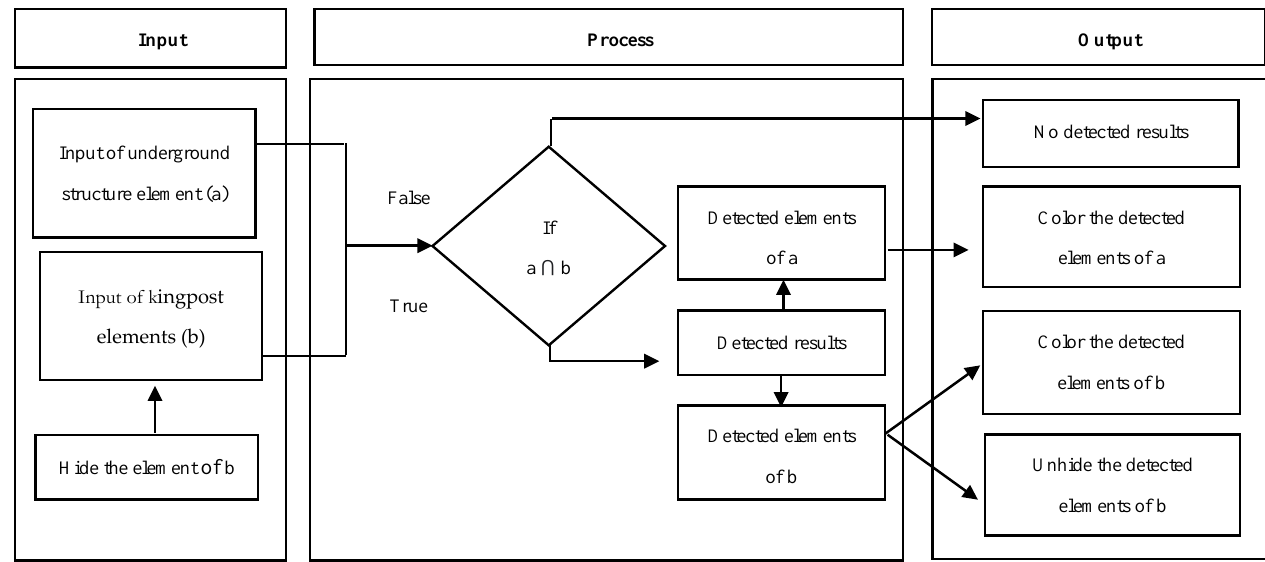
Figure 12. A module of clash detection between kingposts and underground structures.